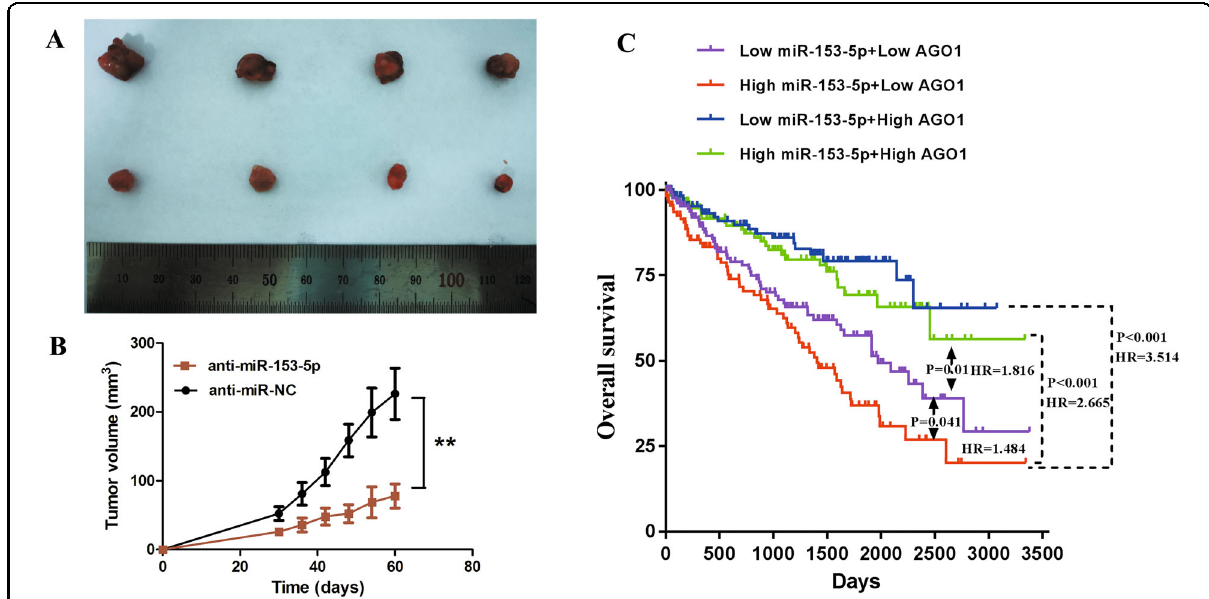
Fig. 7 MiR-153-5p knockdown inhibited tumorigenesis in vivo and miR-153-5p/AGO1 axis serves as a robust prognostic indicator in ccRCC. A , B The tumor growth of 786-O cells infected with LV3-hsa-miR-153-5p inhibitor sponge or LV3-NC. C Prognosis analysis strati fi ed by the expression level of miR-153-5p and AGO1 according to the TCGA dataset. All experiments were conducted at least three independent times and all the values were presented as mean ± SEM. ** P <